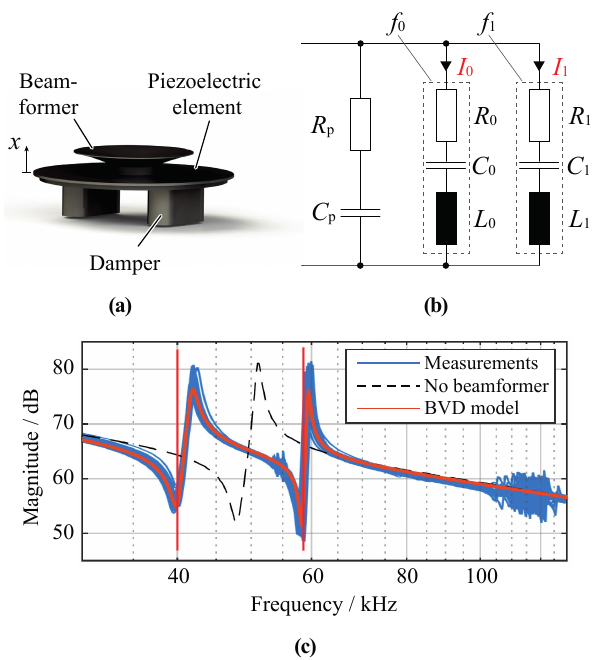
Figure 3. MSO-P1040H07T piezoelectric transducer: ( a ) Annotated rendering of the mechanical structure. ( b ) Equivalent circuit diagram of the Butterworth-Van Dyke (BVD) model showing the resonance paths at f 0 = 40kHz and f 1 = 55kHz. ( c ) Measured magnitude of the impedance and fitted BVD model.